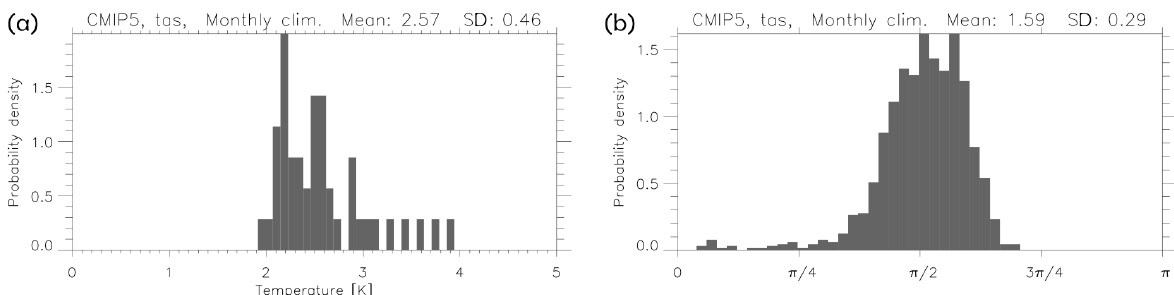
Figure 3. The multi-model 45-member CMIP5 ensemble. Monthly climatology in TAS (K). (a) Distribution of the lengths. (b) Distribution of the angles.